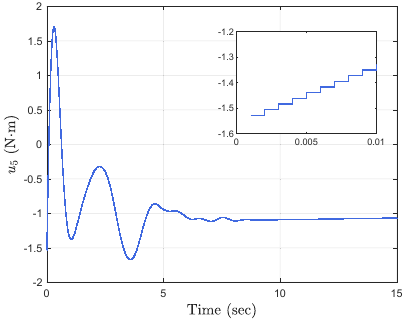
Figure 15. Time − triggered control input u 4 .